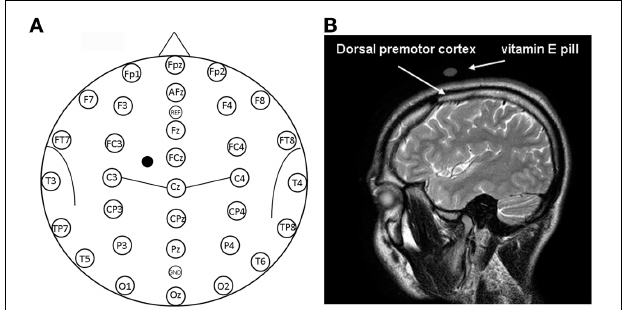
FIGURE 1 | (A) Location of EEG electrodes and point of stimulation. Exemplification of positioning of EEG electrodes used for recordings is reported on a model also indicating some of the main brain sulci. The point on the scalp where TMS was applied is indicated by a mark. (B) Structural magnetic resonance indicating the point of stimulation. Anatomical magnetic resonance acquisition performed in a prototypical subject. The point of stimulation is indicated by the positioning of the vitamin E pill. The positioning of the dorsal premotor cortex is also indicated on the basis of Duvernoy